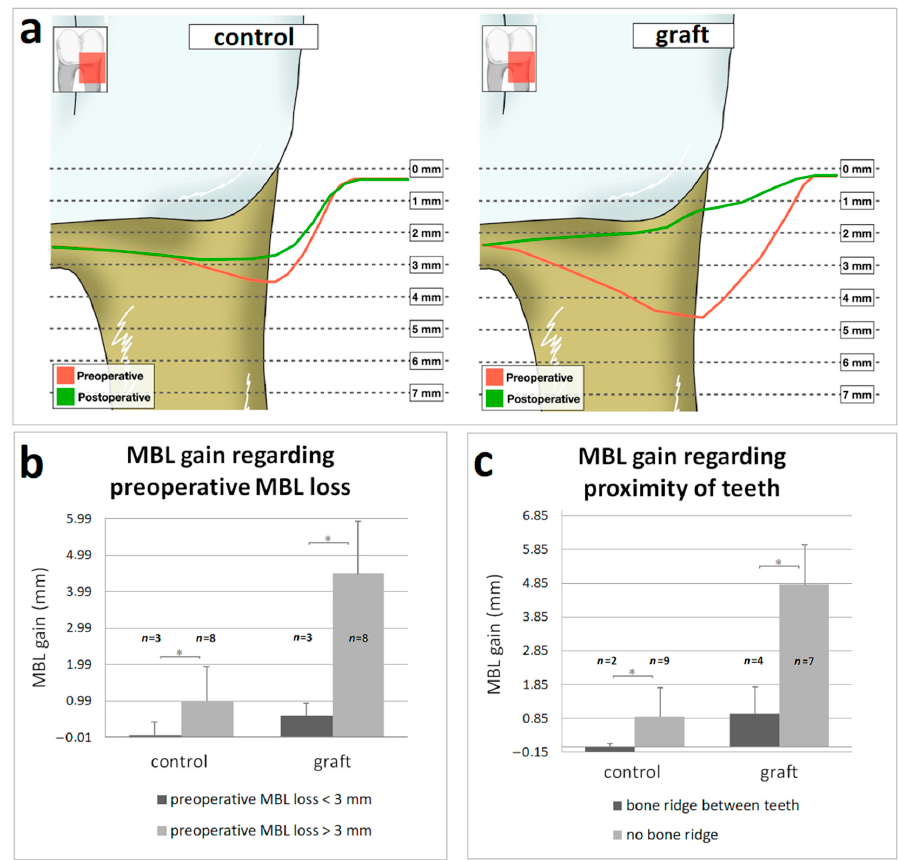
Figure 5. Changes of the marginal bone level (MBL) at the distal site of second molar after 1 year follow-up: ( a ) The results presented regarding to preoperative MBL loss ( b ) and to the proximity of teeth ( c ). Data are presented as mean ( a ) and mean ± SD ( b , c ). Statistical significance ( p < 0.05) was marked by an asterisk. Table 4. Changes of the marginal bone level (MBL) at the distal site of second molar. For statistical analysis One-way ANOVA test (#) was used.